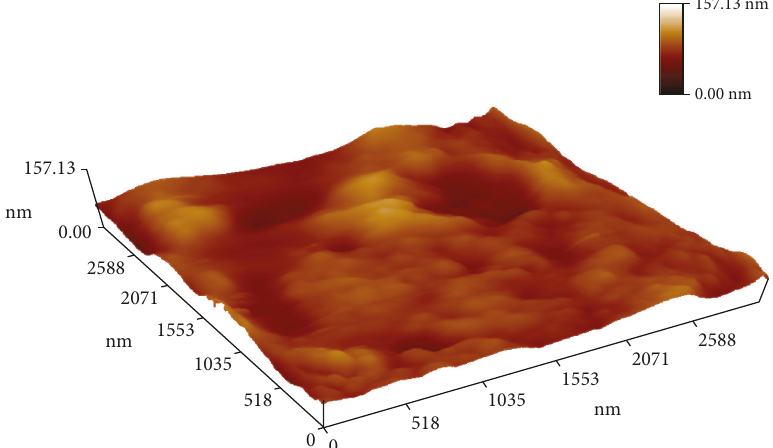
Figure 1: AFM of biosynthesized silver nanoparticles.